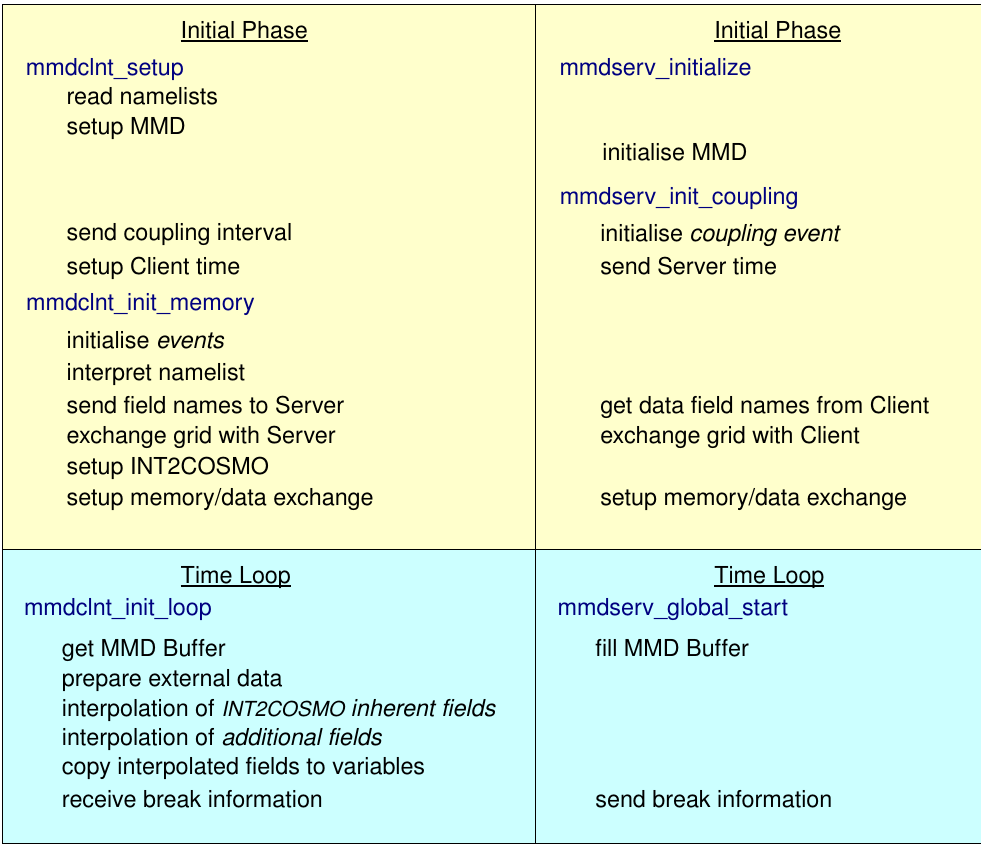
Fig. 5. Work flow of the MESSy submodels MMDCLNT and MMDSERV. The order of the subroutines corresponds to the calling sequence. Subroutines in the same row exchange information/data with each